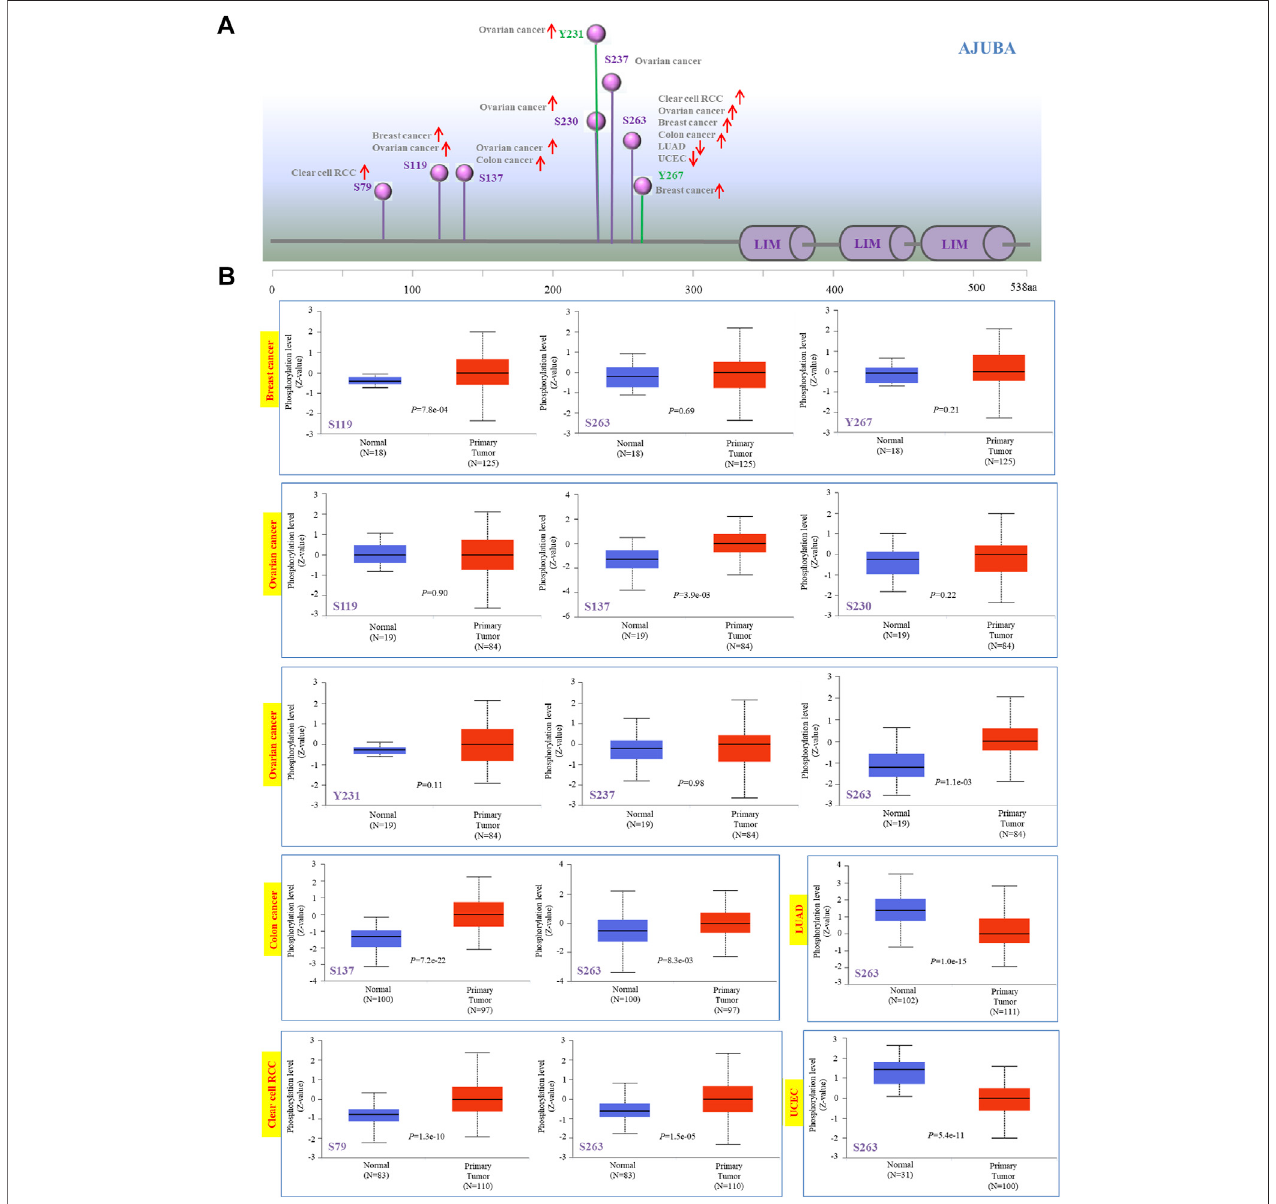
FIGURE 6 | Phosphorylation analysis of AJUBA protein in different cancers. Using the clinical proteomic tumor analysis consortium (CPTAC) dataset, we analyzed the expression level of AJUBA phosphoproteins (S79, S119, S137, S230, Y231, S237, S263, and Y267 sites) between normal tissue and primary tumor tissue through theUALCAN. (A) ThepositiveresultsofphosphoproteinsitesareshownintheschematicdiagramoftheAJUBAprotein. (B) Wealso presented thebox plotsforvarious cancers, including breast cancer, ovarian cancer, colon cancer, lung adenocarcinoma (LUAD), clear cell renal cell carcinoma (RCC), and UCEC.